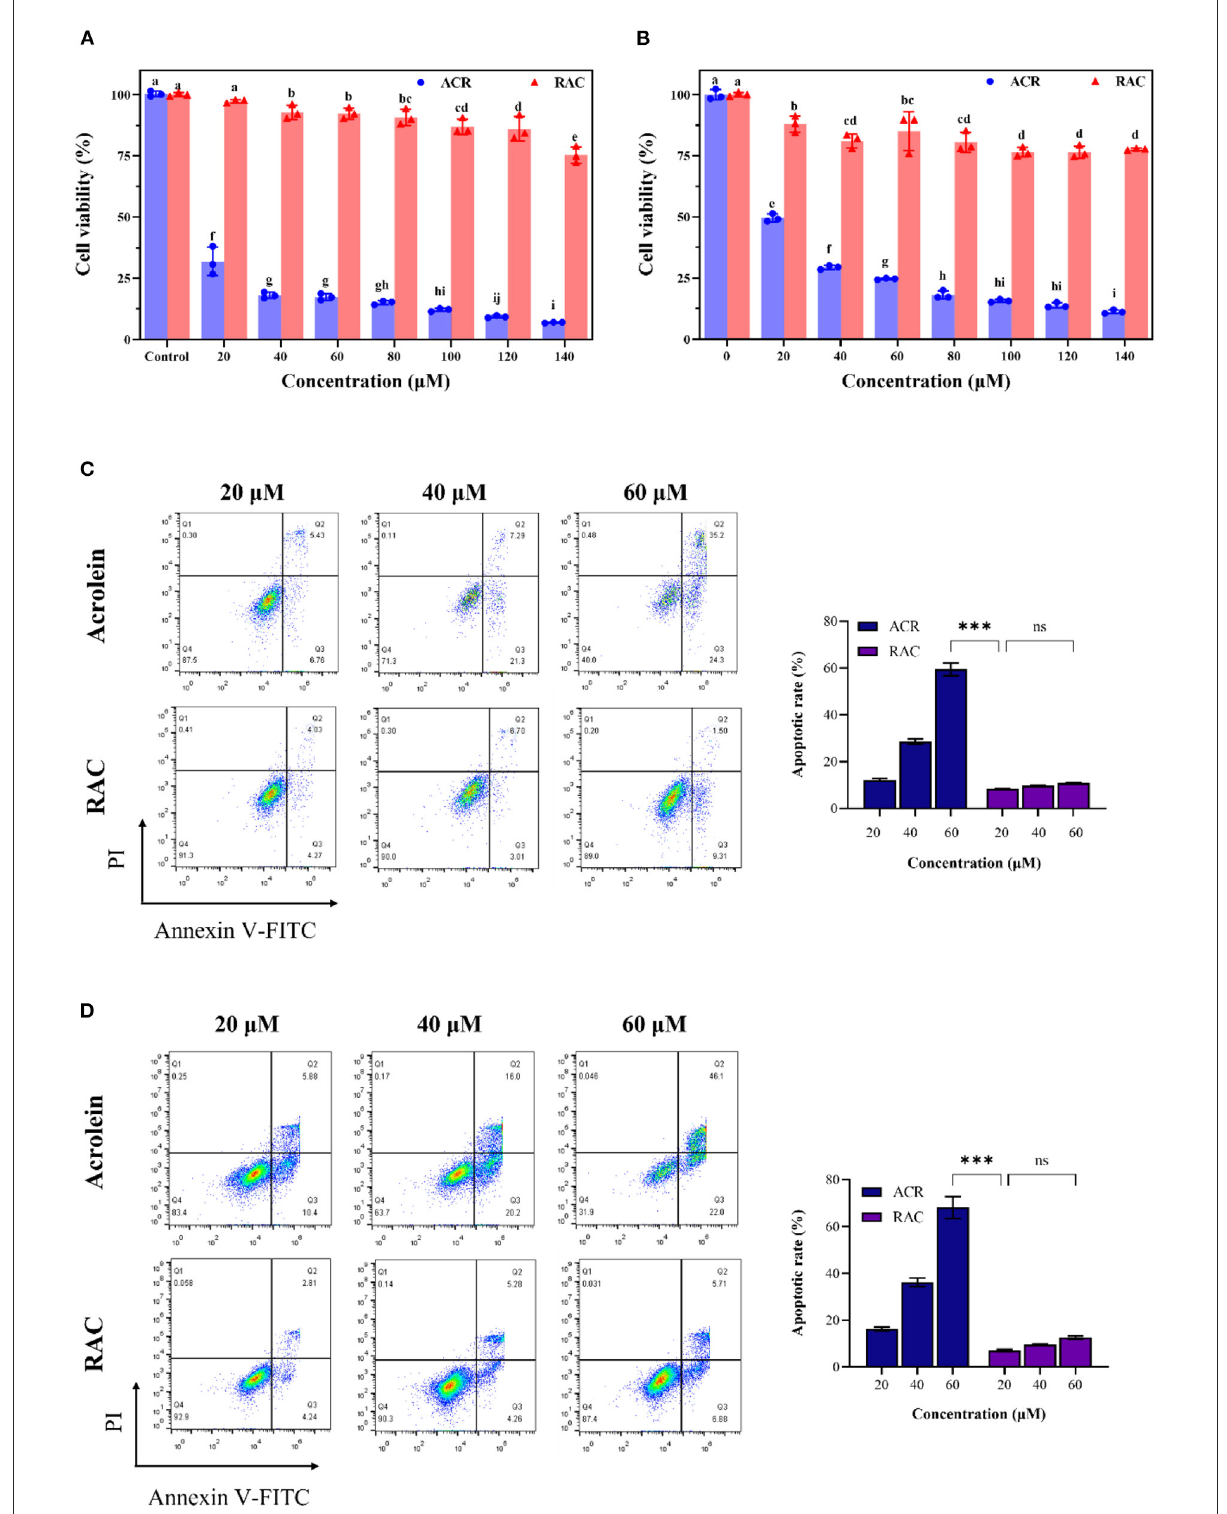
FIGURE6 The cell viability of (A) Caco-2 and (B) GES-1 cells after incubation with ACR (acrolein) and RAC at the concentrations of 20–140 µ M for 48h, and the apoptosis induced by ACR and RAC at the concentrations of 20–60 µ M in (C) Caco-2 and (D) GES-1 cells. Different letters indicated significant differences ( p < 0.05). ***: p < 0.001; ns: not